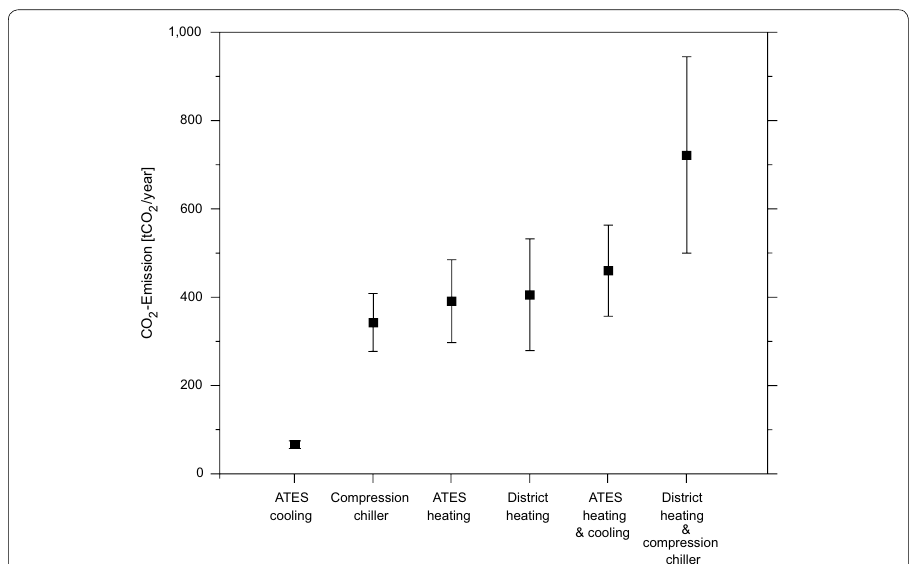
Fig. 10 Annual CO 2 emissions of the compared technologies for the heating and cooling supply of the hospital